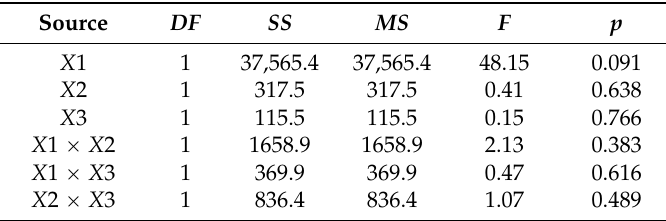
Table 10. ANOVA results including only two-way interactions.